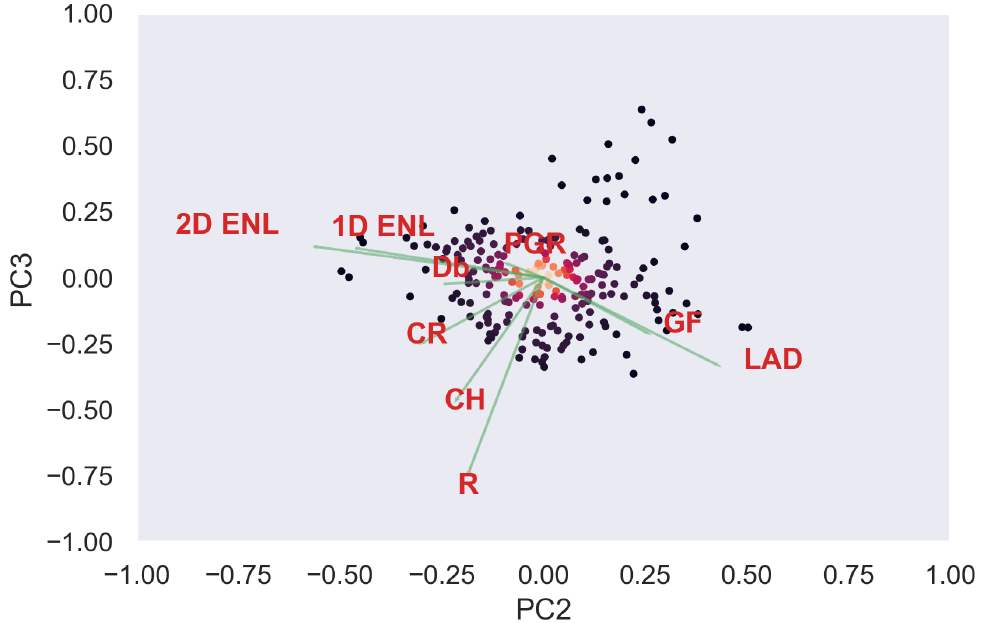
Figure A56. ULS PCA Band 2 and 3 loadings at 5m Grid Size.